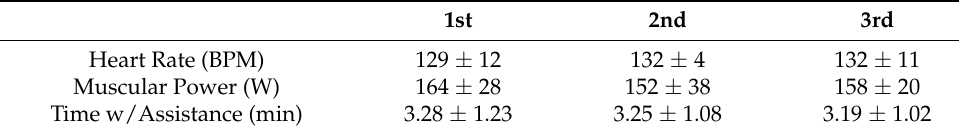
Table 6. Overall outdoor results (mean and standard